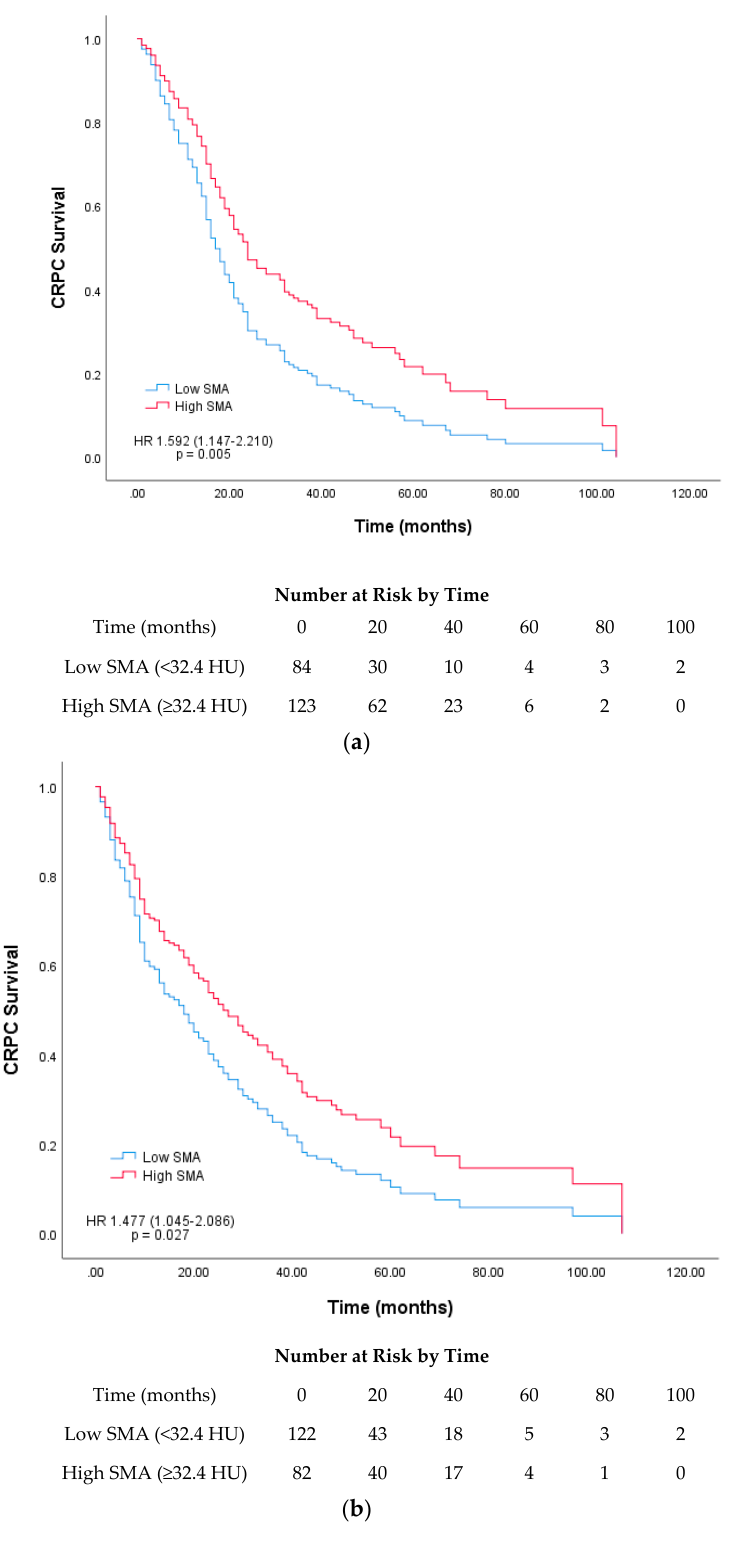
Figure 4. Survival curves based on Cox regression analysis of the survival of patients with castration-resistant prostate cancer (CRPC) stratified according to their median skeletal muscle attenuation (SMA; Hounsfield unit) for the age groups ( a ) <70 and ( b ) >70 years at CRPC diagnosis.